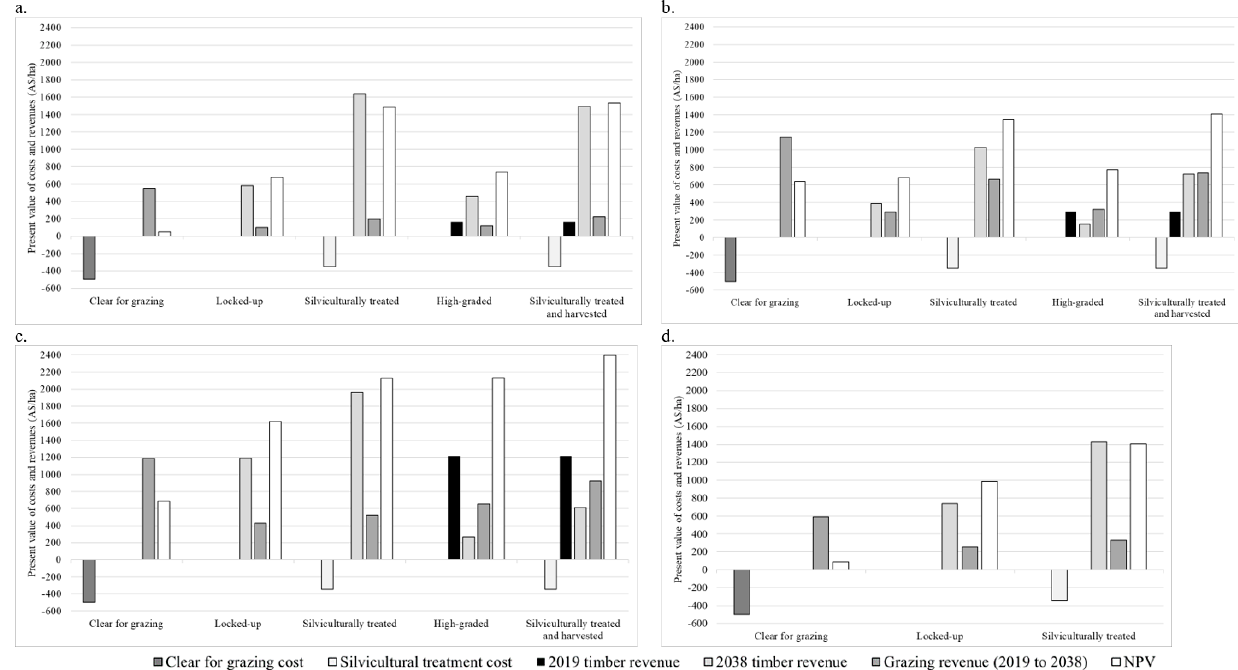
Figure 5 . Present value of costs and revenues, and NPVs per hectare by management scenario. ( a ) Glenbar, ( b ) Gayndah, ( c ) Doughboy, and ( d ) Rathdowney.